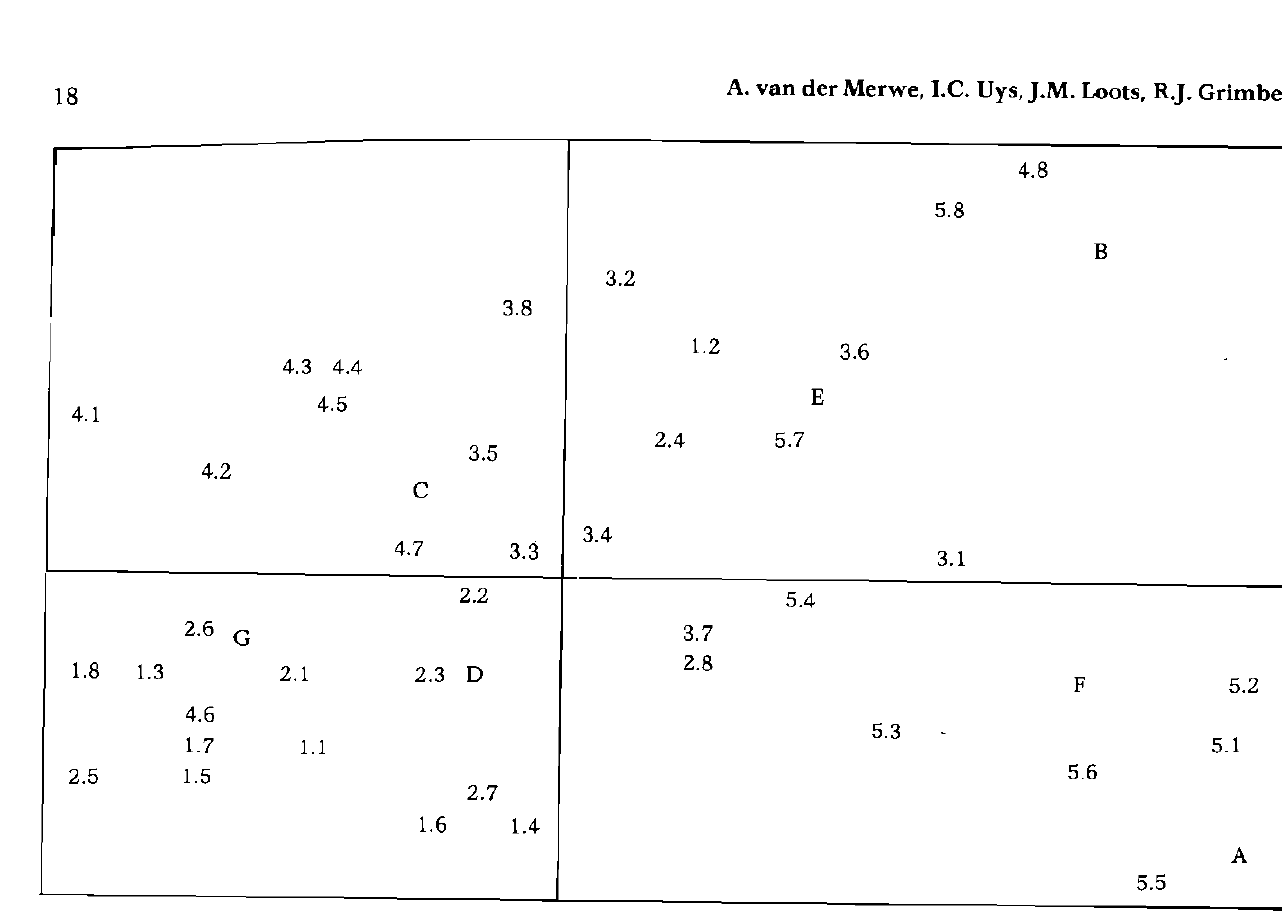
Figuur 2: Resultate van die ooreenstemmingsanalise om die sterkte van assosiasie tussen die eenhede (1.1-5.8) die foutkategoriee (A-G) te illustreer Enkele belangrike assosiasies kan afgelei word uit figuur 1. Foutkategoriee A en Β assosieer die sterkste met S5 en S3. Meer klankvervangings en byvoegings en weglatings van klanke wat die klankstruktuur verander, kom dus voor by die langste